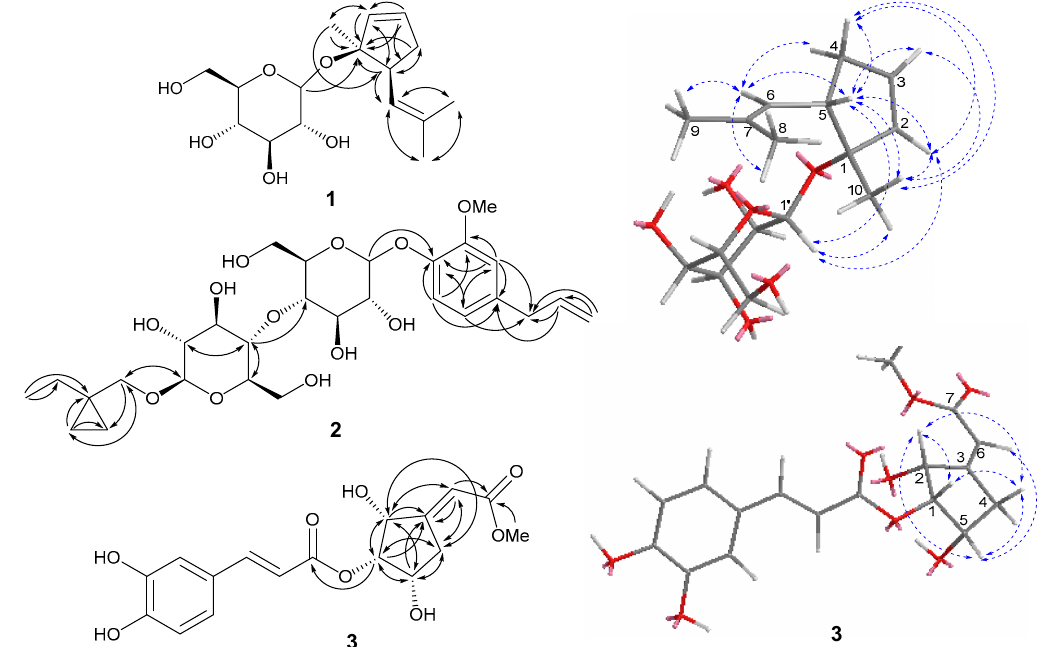
Figure 2 . Key heteronuclear multiple-bond correlation (HMBC) (H C) correlations of 1 – 3 ( left ),